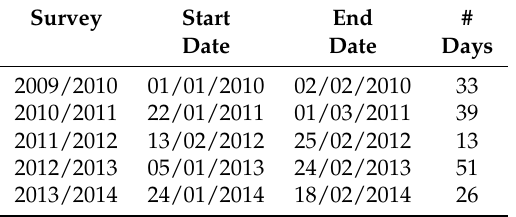
Table 3. Start date, end date, and number of days per survey for the last five studied campaigns.